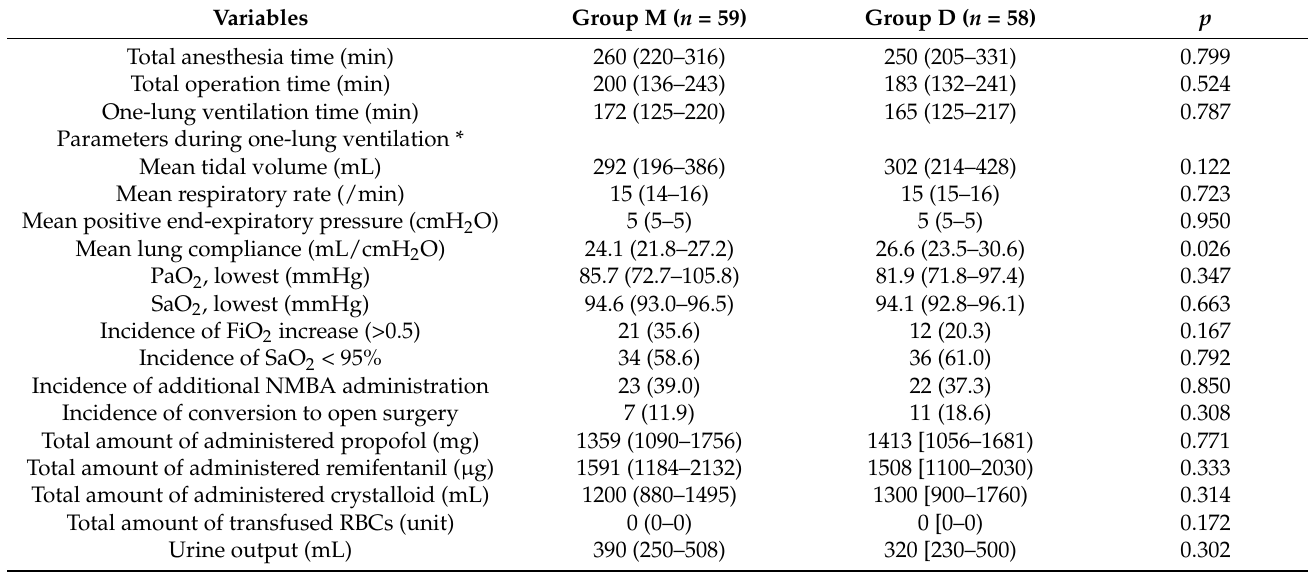
Table 2. Intraoperative